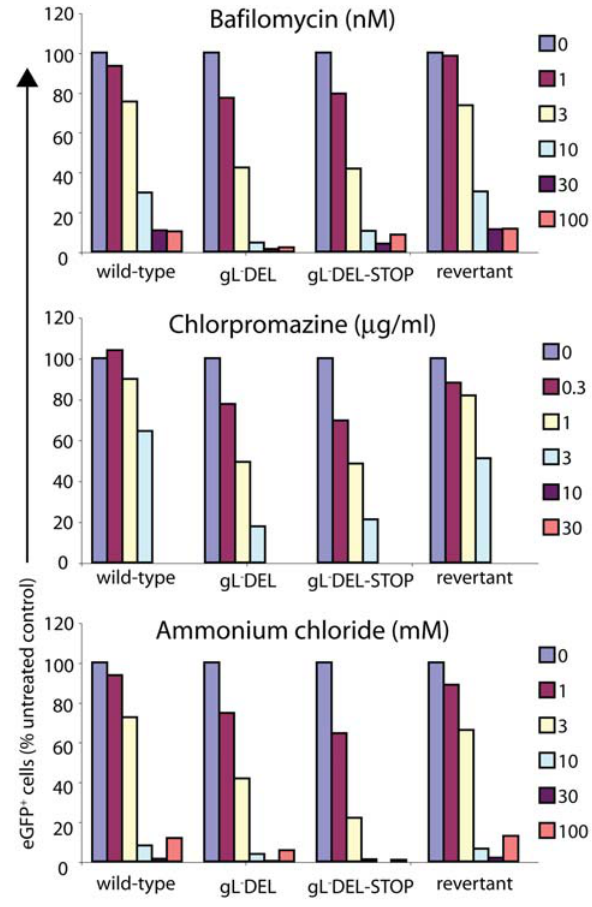
Figure 5. gL-deficient MuHV-4 remains dependent on endocy- tosis and lysosomal acidification. BHK-21 cells were treated as indicated for 2 h, then infected with gL- (gL 2 DEL, gL 2 DEL-STOP) or gL + (wild-type, revertant) MuHV-4 (1 p.f.u./cell). Drug treatment was maintained throughout the course of infection. Infection rates were determined by flow cytometric assay of viral eGFP expression after 18 h. Each point shows the result for 10,000 cells. Equivalent results were obtained in a repeat